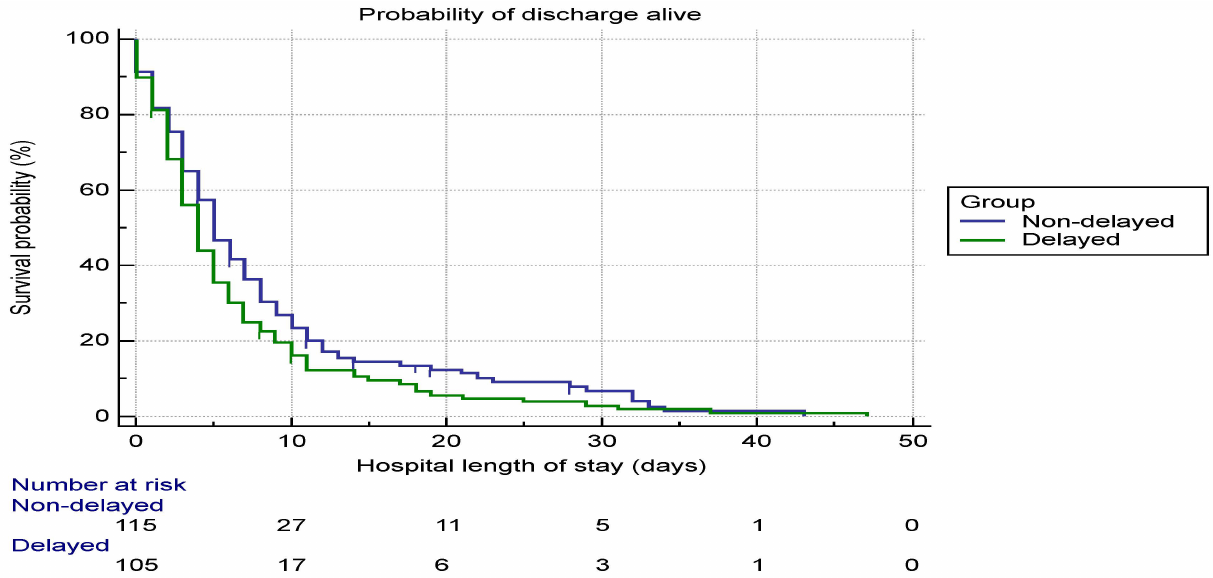
Figure 1. Kaplan–Meier curve of the probability of being alive at discharge among delayed and non-delayed patients based on the length of hospital stay. The main cause of delayed emergency department presentation and 28-day outcome